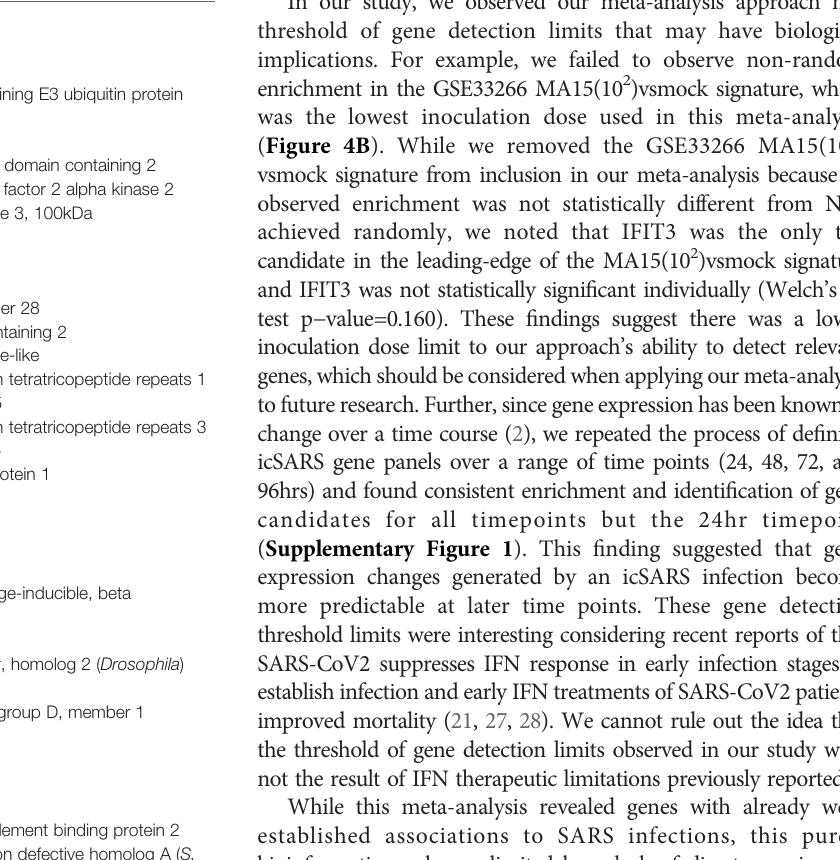
TABLE 6 | Shared Positive icSARS Panel Genes from SARS-CoV2 Datasets Utilized for this Study. ID